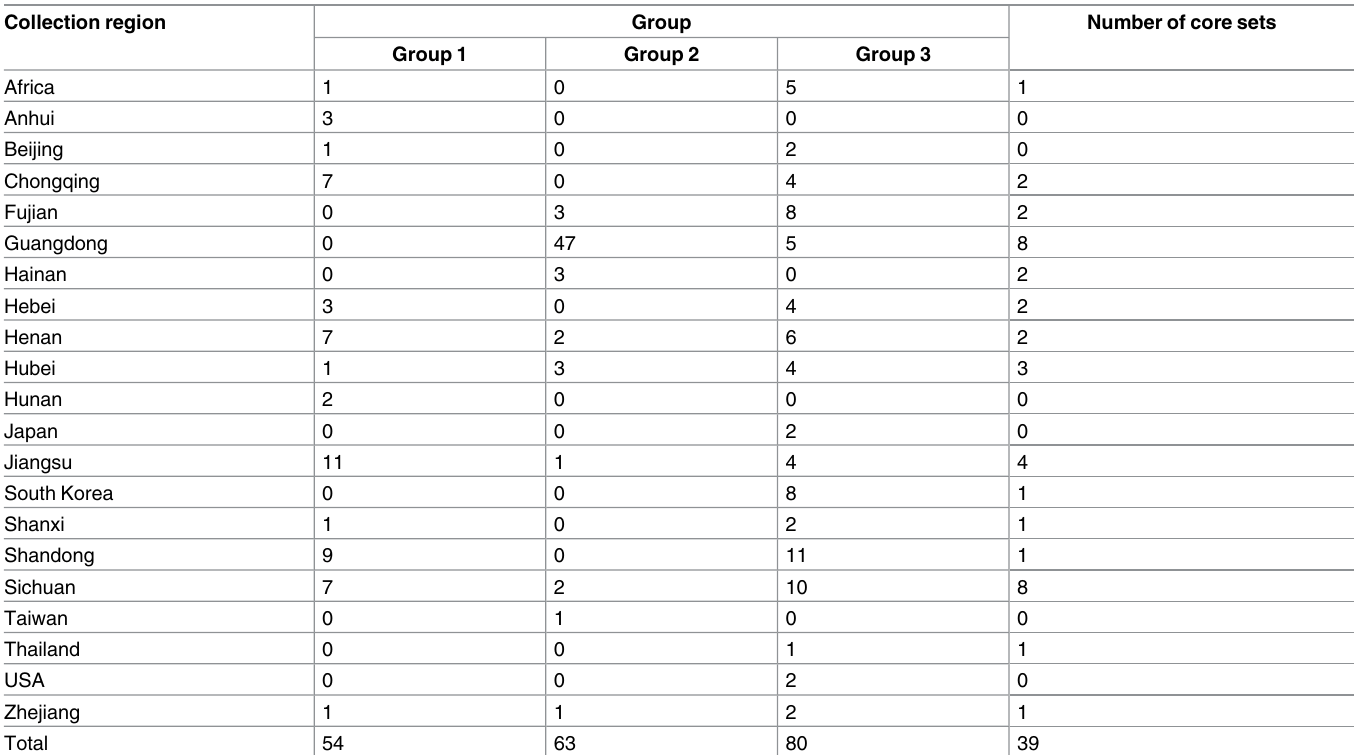
Table 1. Regional distribution of the total collection and the core set in this study.